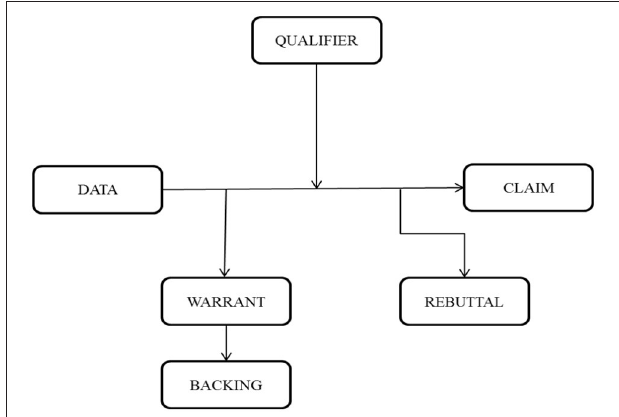
FIGURE 1 | Toulmin’s model of argument (Toulmin, 1958, p. 97). This figure summarizes the theoretical perspective employed in analyzing the